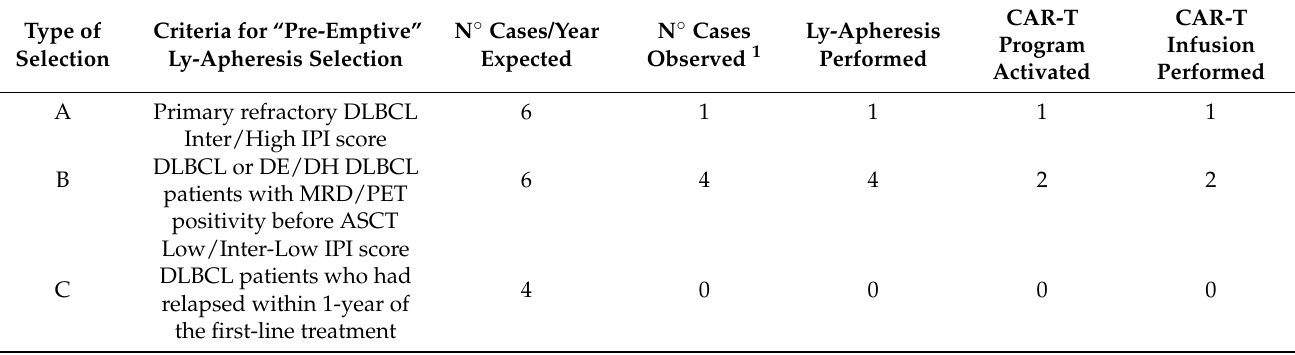
Table 1. Pre-emptive Ly-apheresis program guidelines. ASCT, autologous stem cell transplantation; CAR, chimeric antigen receptor; DE, double-expresser; DH, double-hit; DLBCL, diffuse large B-cell lymphoma; IPI, International Prognostic Index; Ly, lymphocytes; MRD, minimal residual disease; N ◦ , number; PET, positron emission